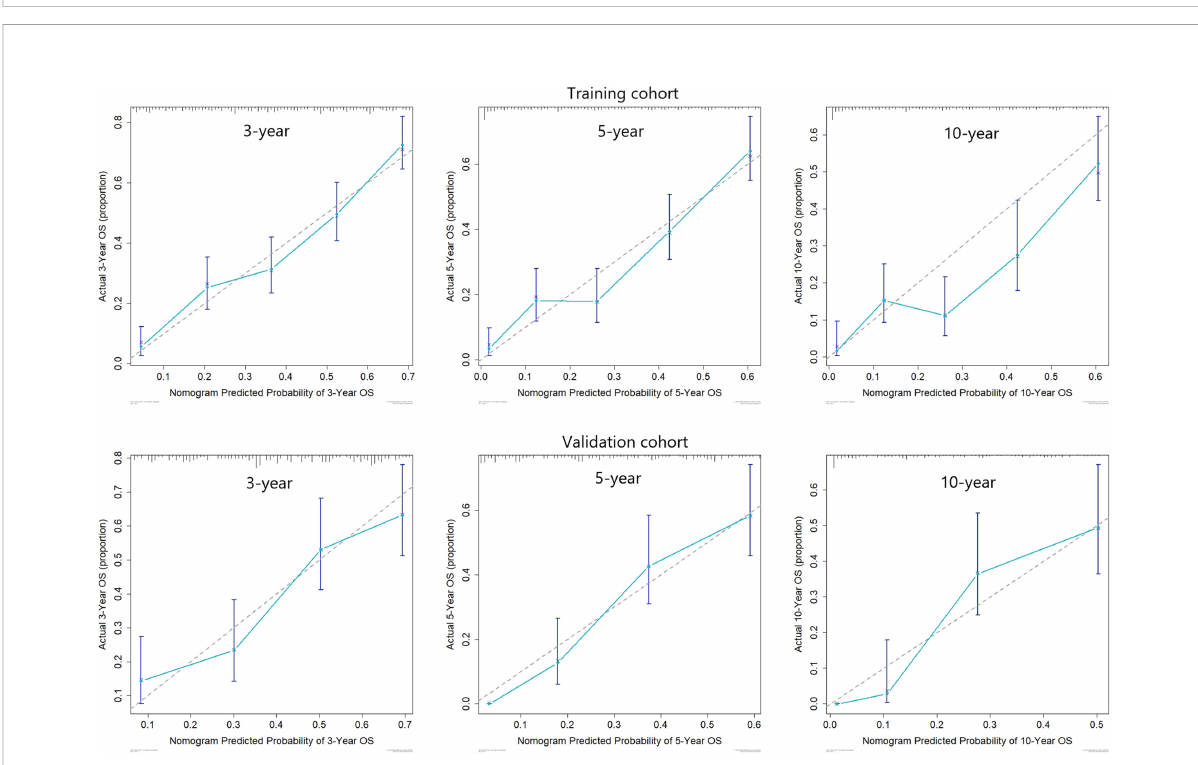
FIGURE 3 Calibration curves for 3-, 5-, and 10-year OS among patients with FIGO stage III/IV ECCC within the training and validation